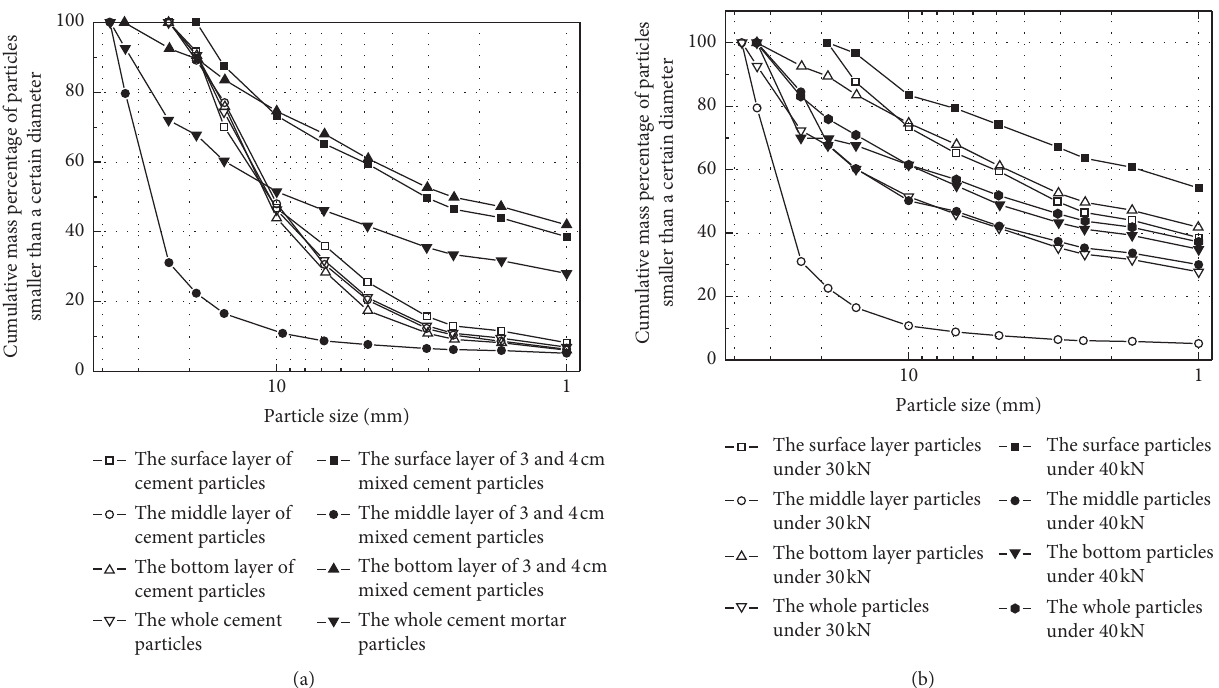
Figure 14: The stratified sieving curves: (a) 3 and 4cm mixed cement mortar and cement particles under the loading of 30kN; (b) 3 and 4cm mixed cement mortar particles under the loading of 30 and 40kN.